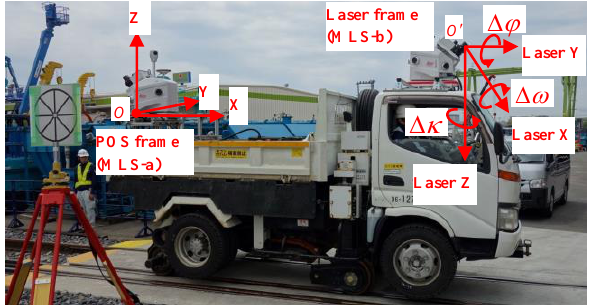
Figure 2. Two MLSs are deployed on the railway